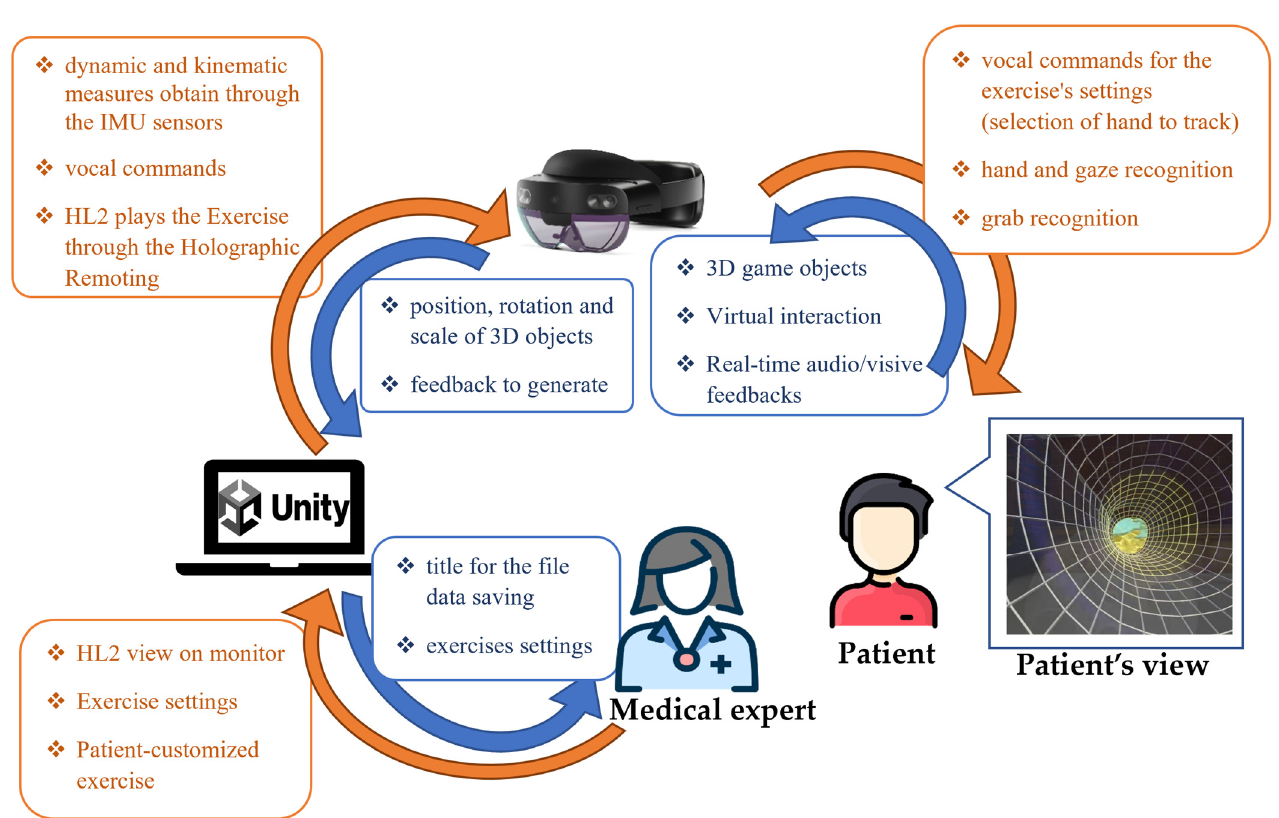
Figure 2. Scheme of input/output across the PoC: HL2, computer, medical expert interface interactive for clinician and the patient that wears HL2.